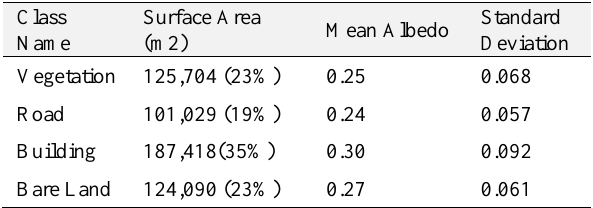
Table 1. Mean albedo and standard deviations of various land covers found in the study